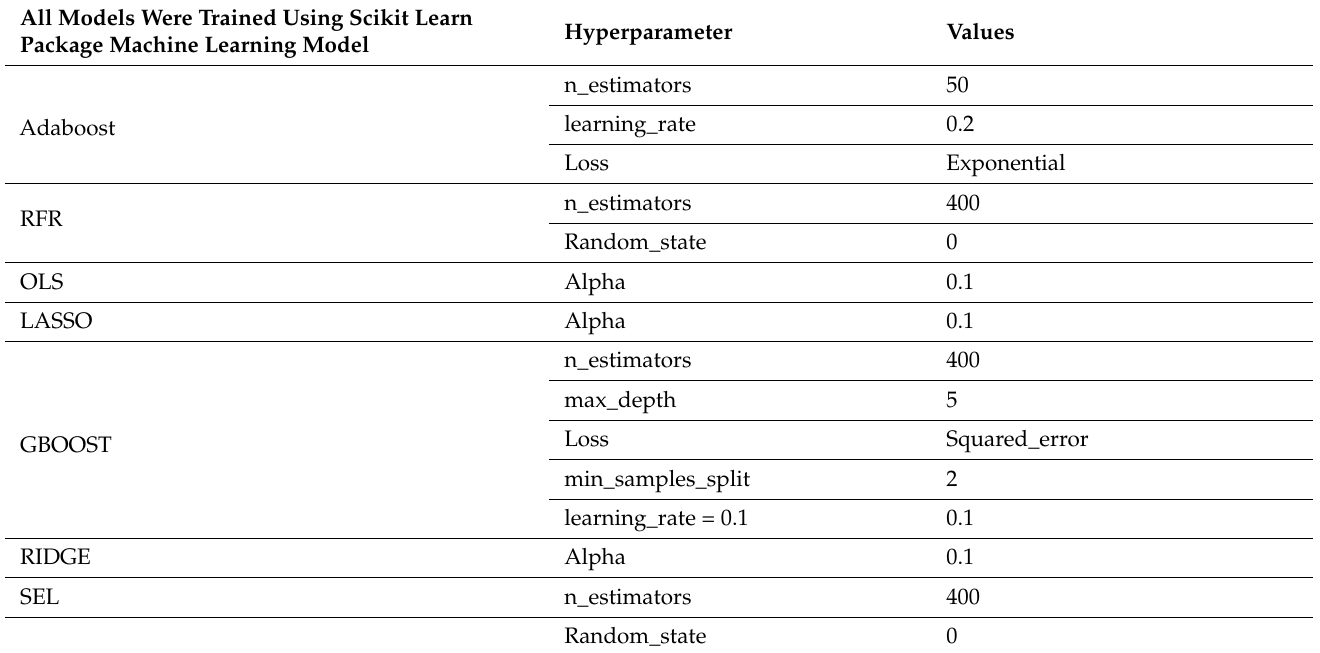
Table 2. Experimental configuration and parameters tuning of Adaboost, GBOOST, RF, OLS, LASSO, RIDGE and